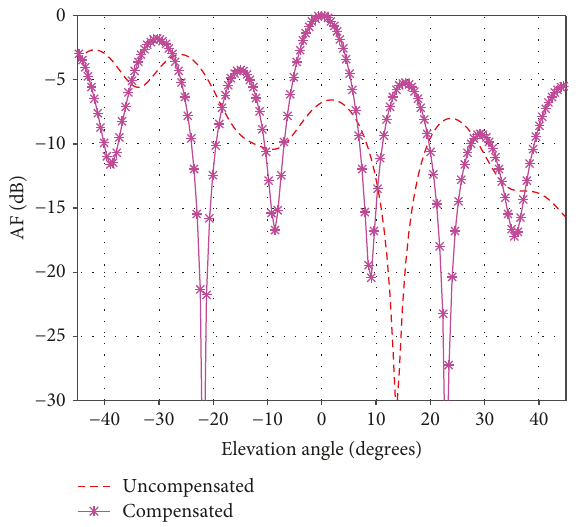
Figure 9: Array pattern of the 6-element MRA 15322 with = 13 , bent in the yz -plane. N a Table 2: Phase compensation at individual elements in bent ULA and bent